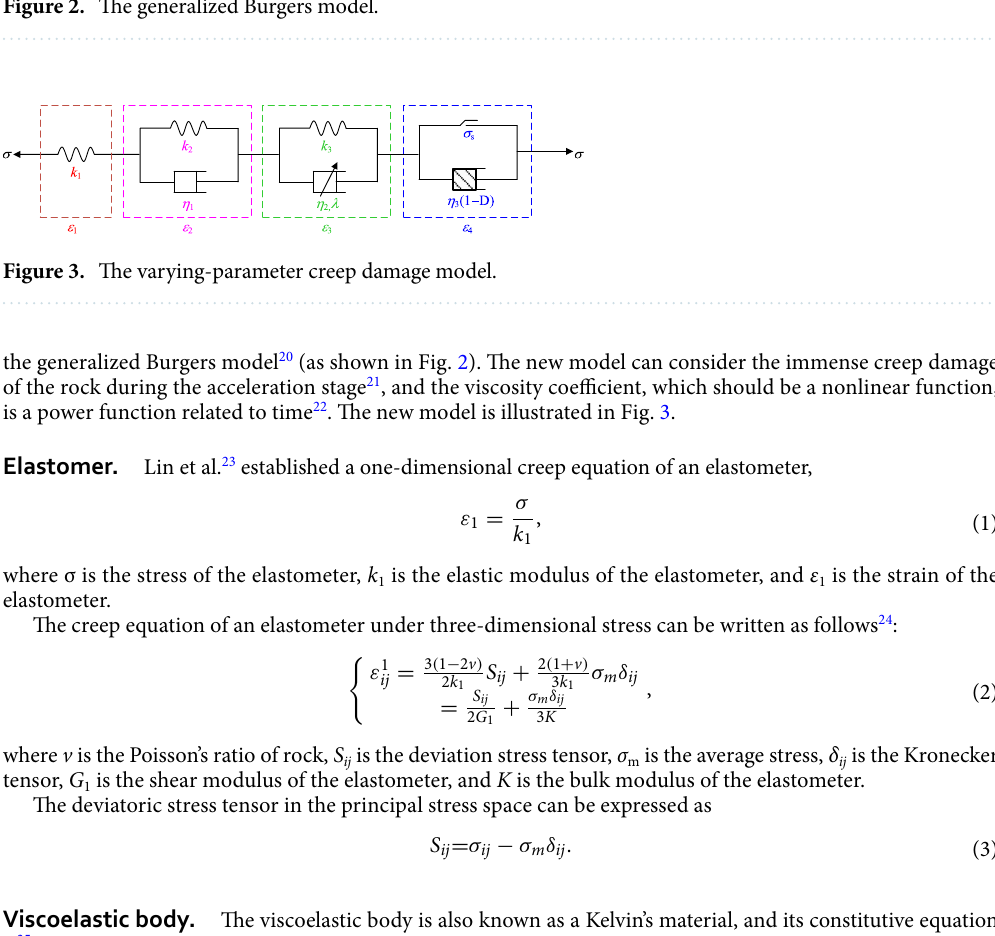
Figure 2. The generalized Burgers model.